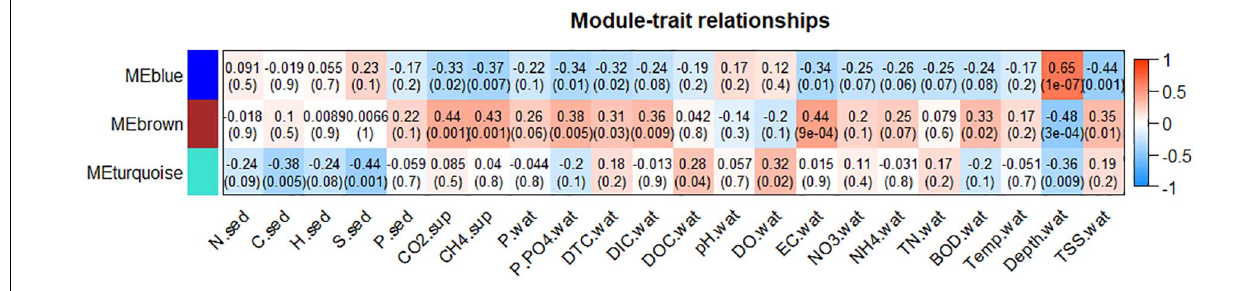
( p = 0.4533), Crenothrix ( p = 0.6185) ( Gammaproteobacteria ), and Methylocystis spp. ( p = 0.2700) ( Alphaproteobacteria ) ( Supplementary Table 3